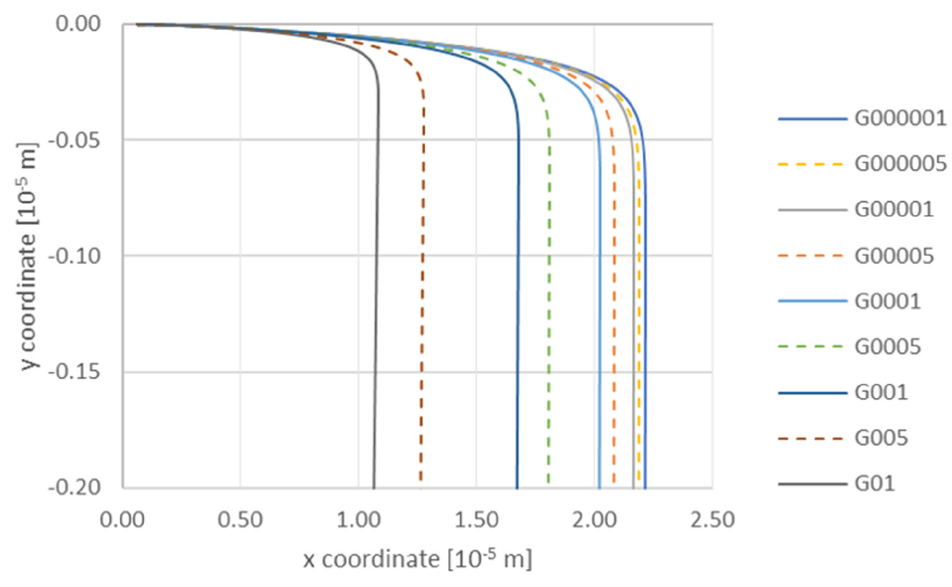
Figure 9. Analysis of influence of gradient on the trajectory of a TiC particle with a radius 7.75 × 10 − 8 m under the conditions of viscosity 0.0015 Pa·s. Gradient, m/s: G000001—0.00001; G000005—0.00005; G00001—0.0001; G00005—0.0005; G0001—0.001; G0005—0.005; G001—0.01; G005—0.05; G01—0.1.